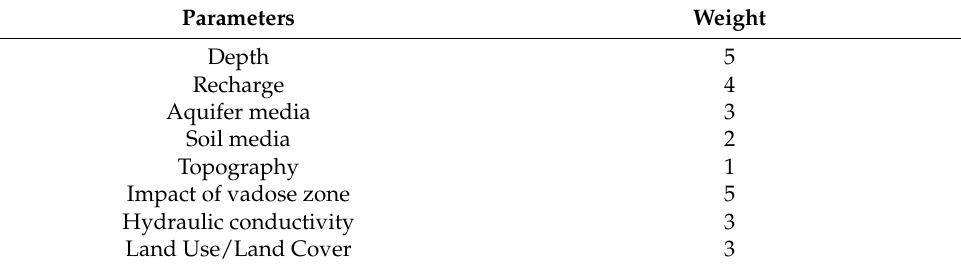
Table 1. Assigned weights for DRASTIC-LU parameters.